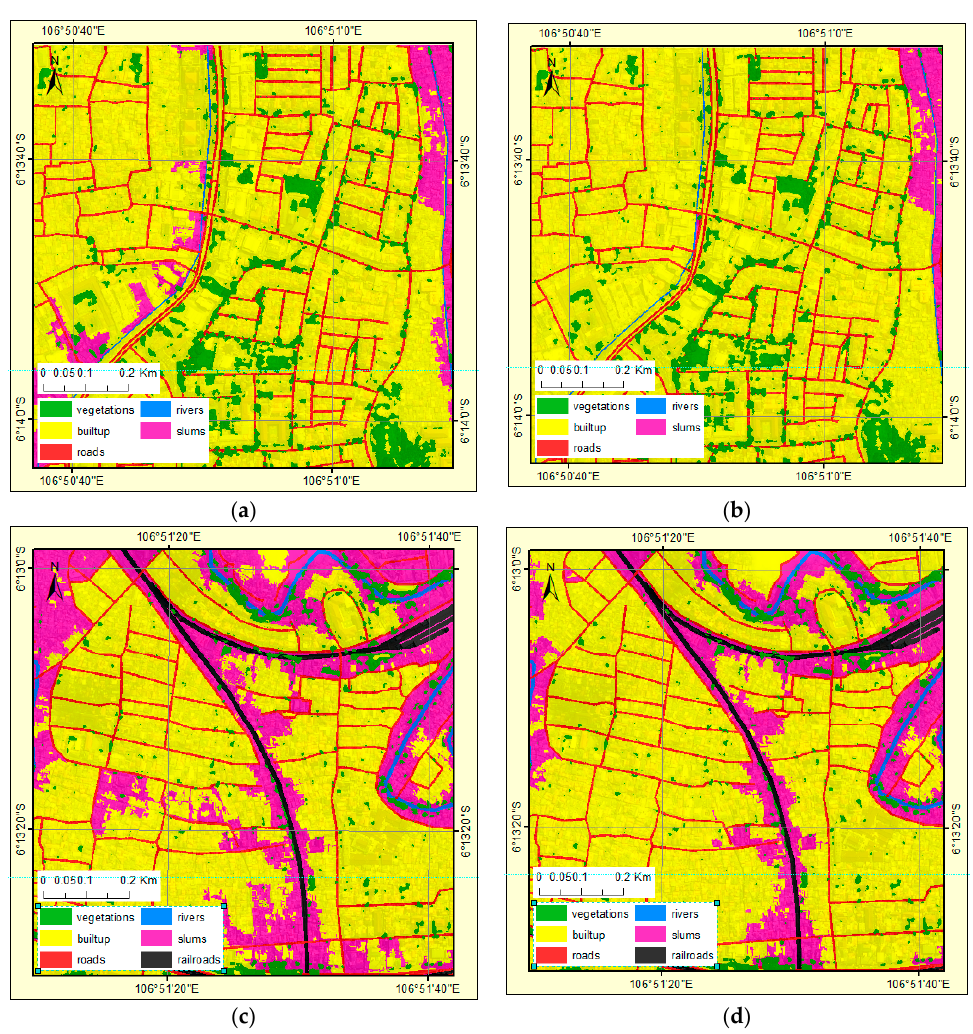
Figure 7. Mapped slums in the first test area ( a , b ). ( a ) indicates slums without the tenure indicator (only consider explicit indicators); ( b ) indicates slum employing the tenure indicator. Meanwhile, ( c , d ) indicates slums in the second area, by including and excluding the tenure indicator, respectively.